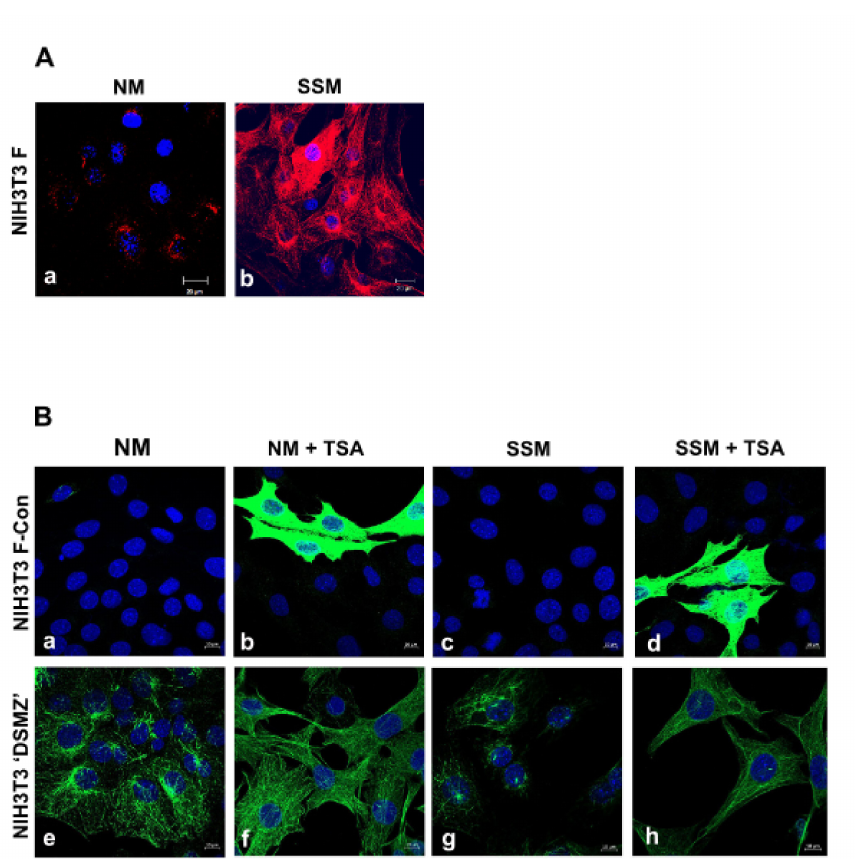
Figure 5. Acetylation of cytoplasmic tubulin in NIH3T3 F, NIH3T3 F-con, and NIH3T3 “DSMZ” sub-cell lines. ( A ) Cytoplasmic tubulin acetylation in NIH3T3 F cells increased in serum-starved medium. Cells were seeded at 2 × 10 5 cells per 6-well plate in normal medium (NM) and cultivated for 24 h. Thereafter, the medium was exchanged for serum starvation medium (SSM), and cells cultivated a further 48 h. Immune decoration for acetylated α -tubulin (red). Nuclear counterstain with DAPI (blue). Bars: 20 µ m. ( B ) Cytoplasmic tubulin acetylation in NIH3T3 F-con cells (derived from NIH3T3 F cells) and NIH3T3 “DSMZ” cells dependent on culture conditions and TSA-mediated HDAC6 inhibition. NIH3T3 sub-cell line F-con ( a – d ) and newly obtained NIH3T3 cells from DSMZ ( e – h ) were cultivated in standard medium (a,b,e,f; NM) or serum starvation medium (c,d,g,h; SSM) either in the absence of TSA (a,c,e,g) or in the presence of TSA (b,d,f,h; +TSA). To demonstrate even a low amount of cellular tubulin acetylation pictures in a to d were captured by overexposure. Decoration of acetylated tubulin in green, nuclear counterstain with DAPI in blue. Bars: 10 µ